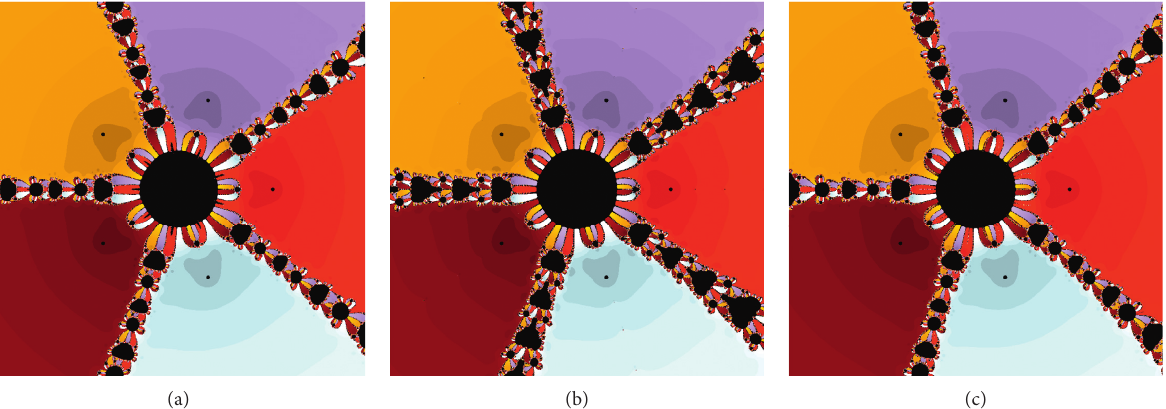
Figure 6: Basins of attraction associated with the polynomial p Algorithm